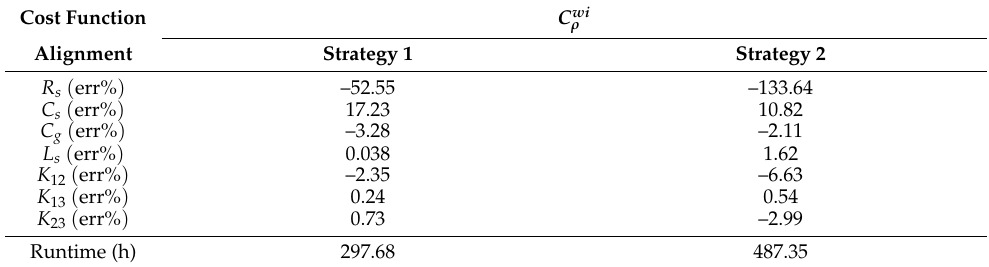
Figure 10. Inferred EMD Cost Function C i ρ versus Distance from the Target Model Parameter [28]. (© 2023 IEEE. Reprinted, with permission, from EEEIC/I&CPS Europe). Table 5. Estimated Model Parameter Error Percentages obtained through the Weighted IEMD approach.